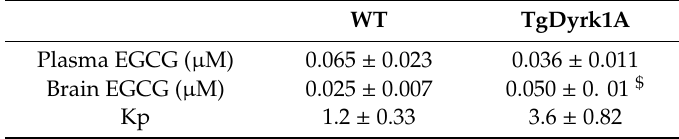
Table 6. Plasma and brain EGCG levels in WT mice and mice overexpressing Dyrk1A (TgDyrk1A) that have received on oral gavage of intermediate (D2) dose of FontUp during two days. WT